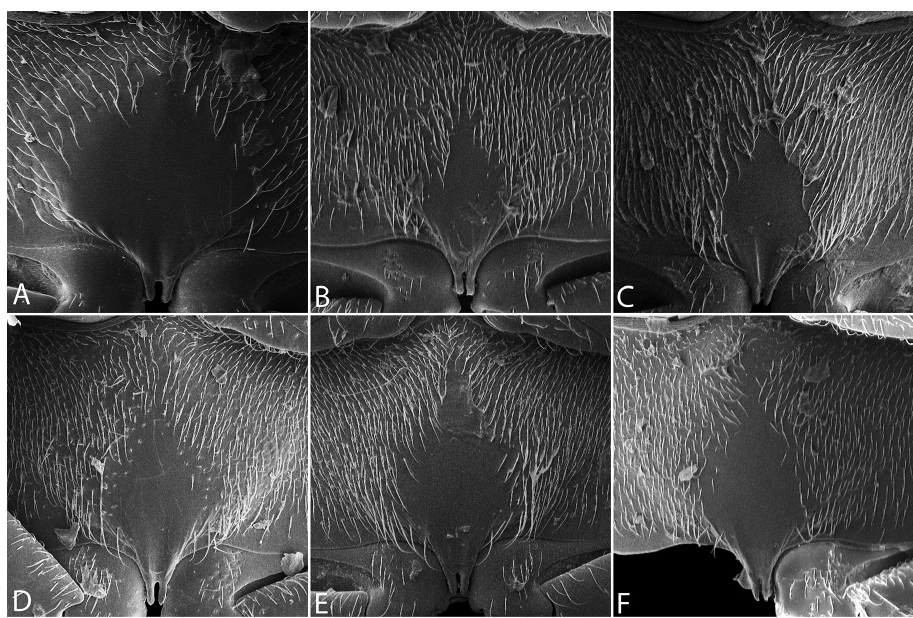
Figure 10. Metaventrite of Tobochares spp. A T. canthus sp. n. B T. canaliculatus sp. n. C T. pallidus sp. n. D T. kasikasima E T. sipaliwini F T. striatus